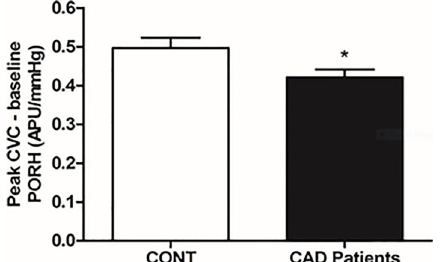
Figure 3. Effects of post-occlusive reactive hyperemia (PORH) on skin cutaneous microvascular conductance [CVC, expressed in arbitrary perfusion units (APU) divided by mean arterial pressure in mmHg] in healthy volunteers (CONT) and male patients with coronary artery disease (CAD). *P o 0.05, compared to control (two-tailed unpaired Student ’ s t